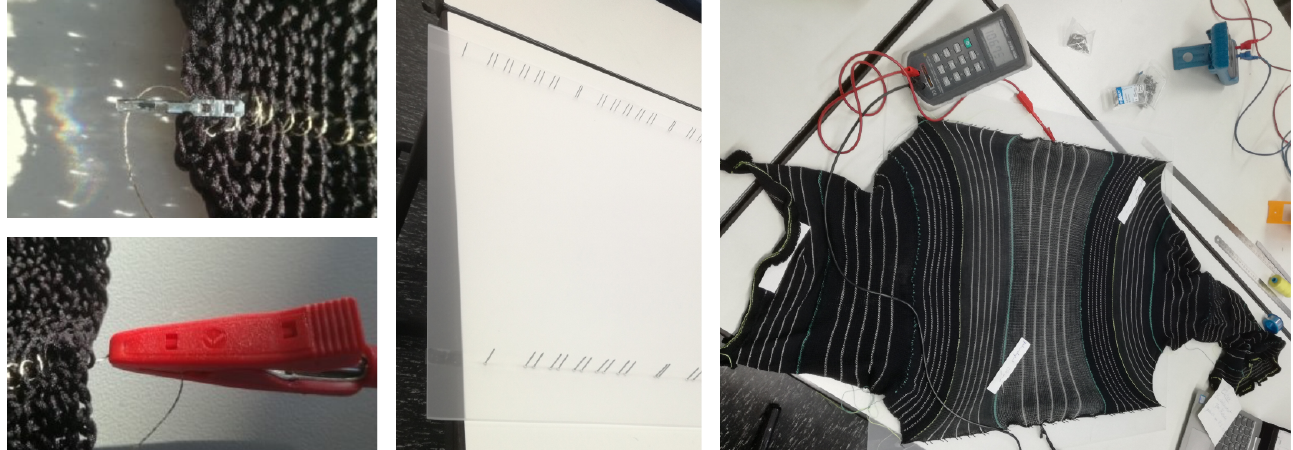
Figure 3. Resistance measurement: unsatisfactory crimp connection ( left , top ), alternative method using clamps ( left , bottom ), fastening device ( middle ), fastening device with mounted test vehicle and multi-meter measuring setup ( right